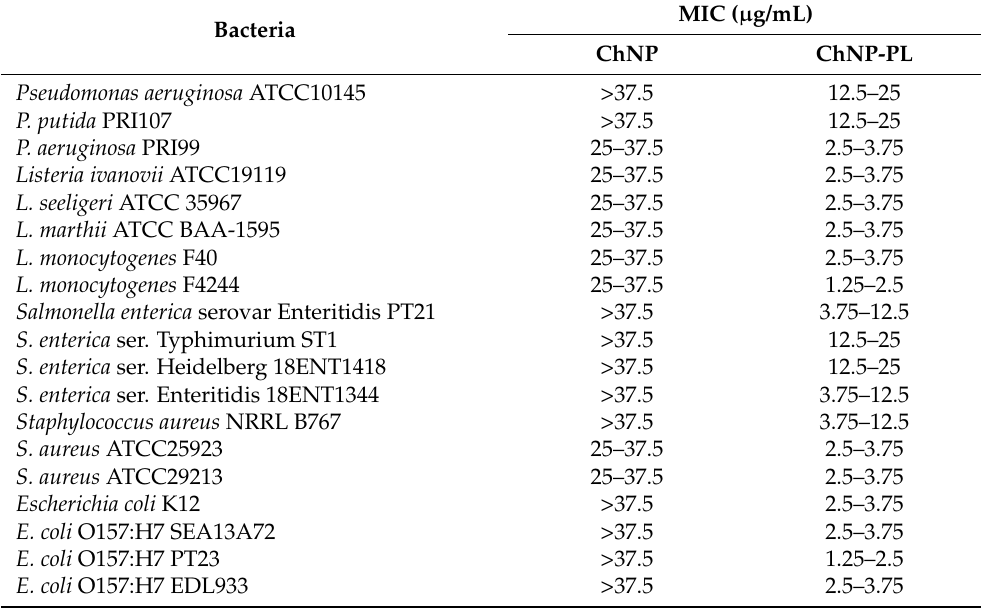
Table 1. Comparison of Minimal Inhibitory Concentration (MIC) values of ChNP and ChNP-PL. Bacteria